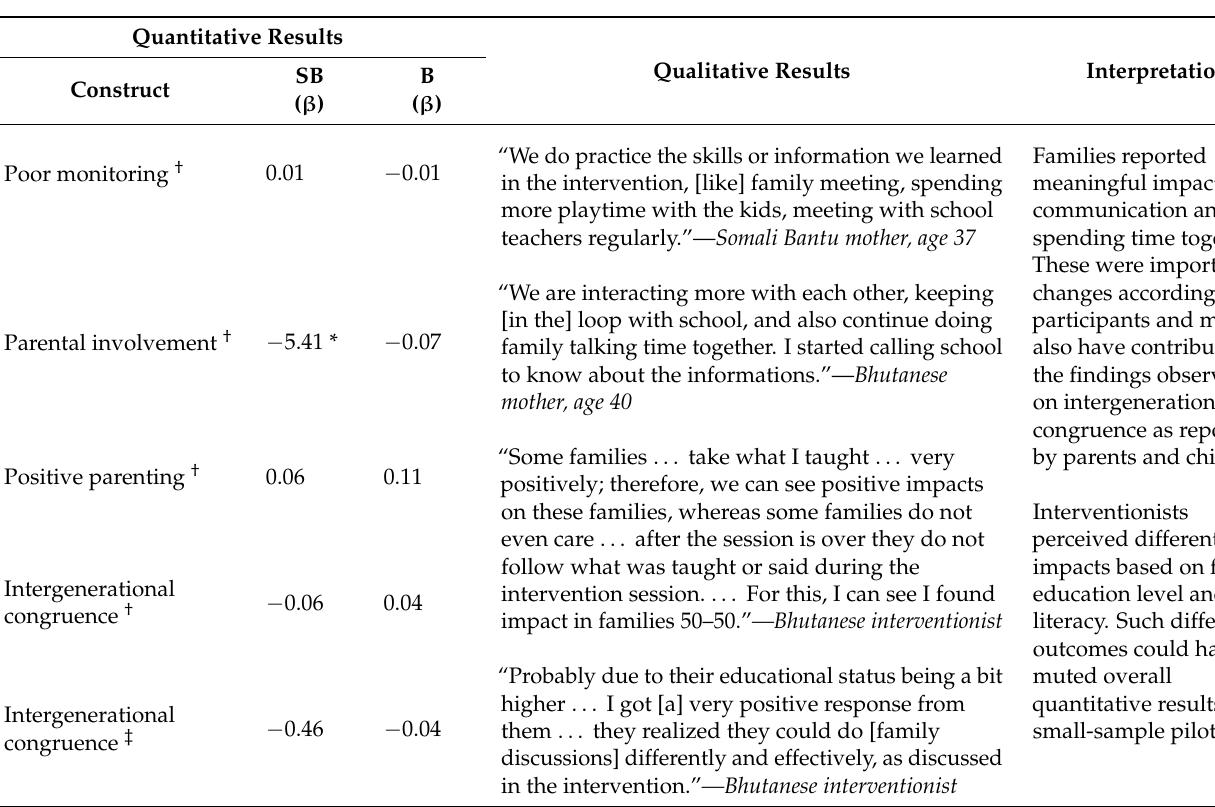
Table 2. Joint display table: Integration of quantitative (point estimates comparing pre- to post- test change of the intervention versus CAU participants) and qualitative (interview data) about family